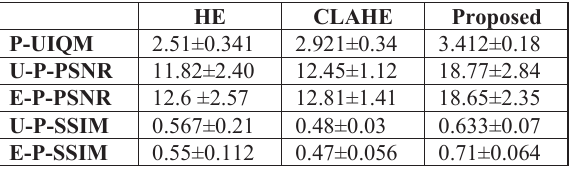
Table 3. Performance evaluation parameter on input, output and HE CLAHE